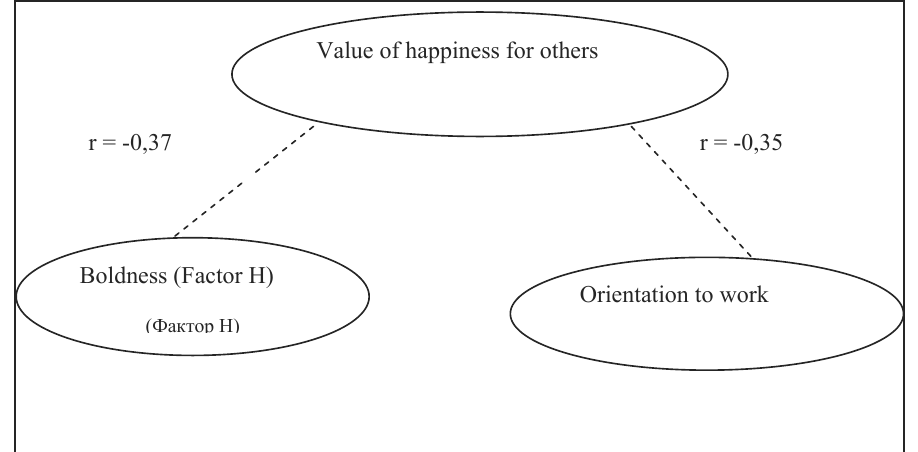
Fig. 1.5. Correlation between a value of happiness for others with boldness (Factor H) and orientation to